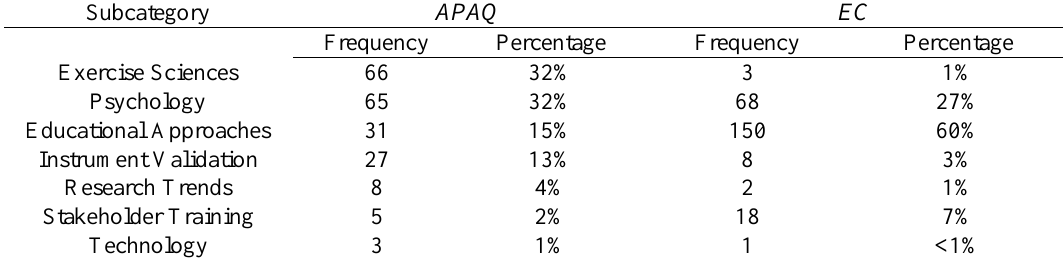
Table 3 identifies the frequencies and percentages of publications across APAQ and EC over the ten-year span by topical